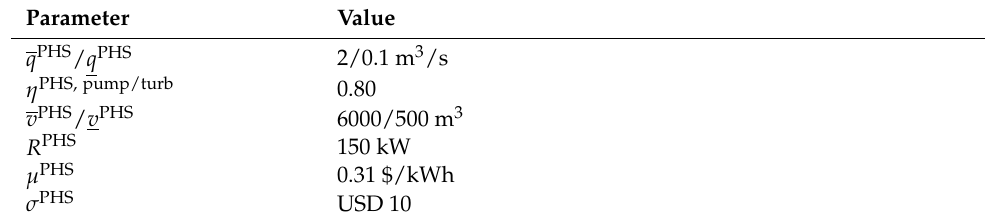
Table 6. PHS data [34].